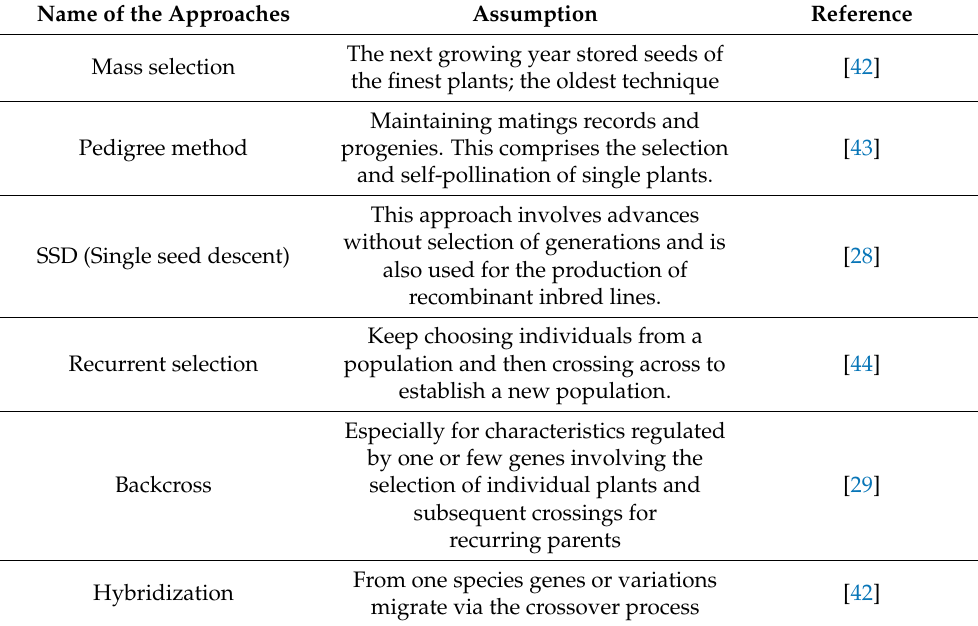
Table 2. Major traditional approaches are employed in programs of Capsicum